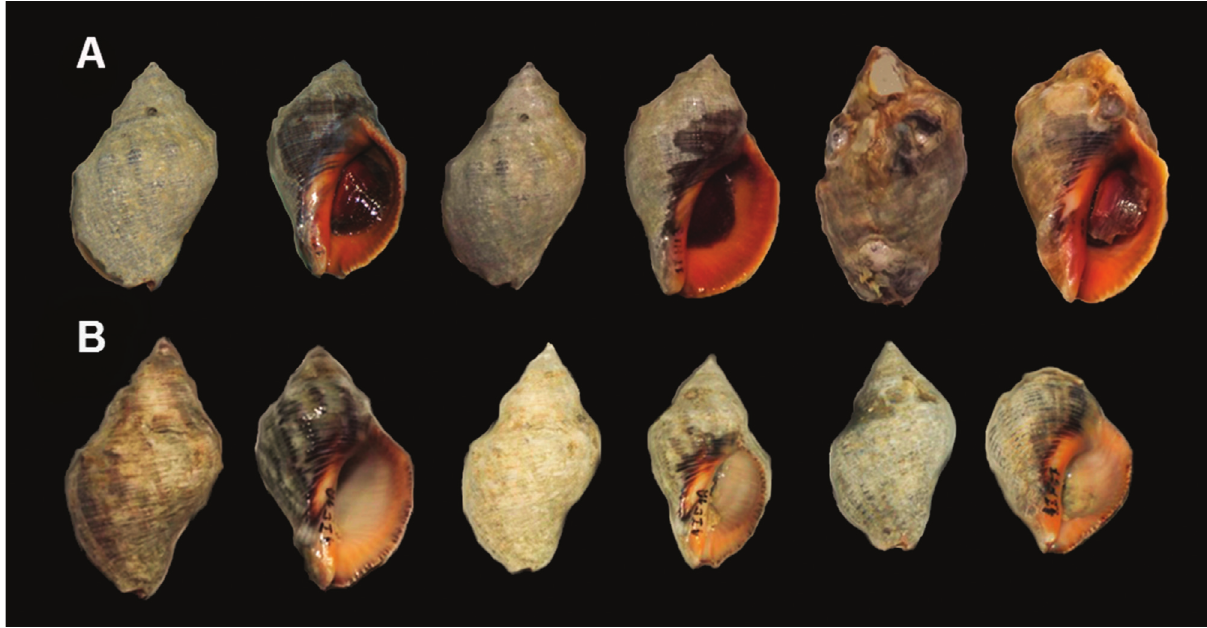
Figure 1 - Color variation and shape of shells of Stramonita cf. haemastoma (A) and S. brasiliensis